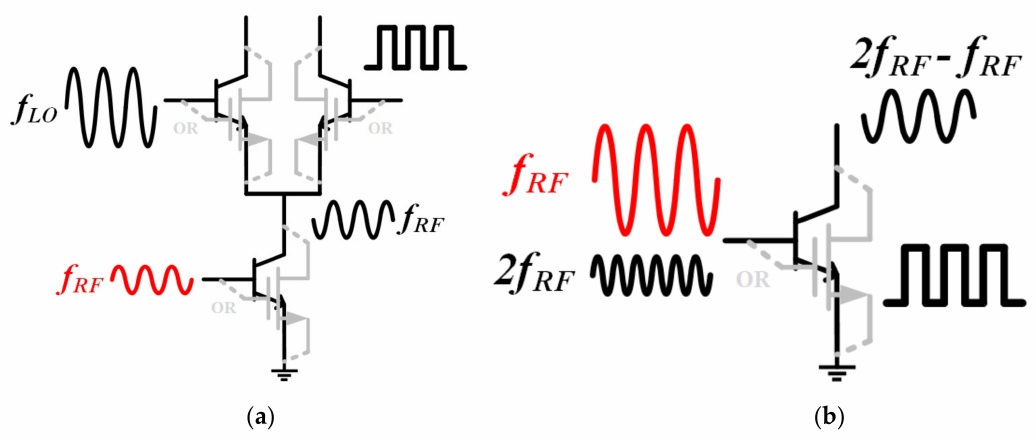
Figure 3. Circuit behaviors under “reverse uplift”. ( a ) Traditional mode, ( b ) switching mode.